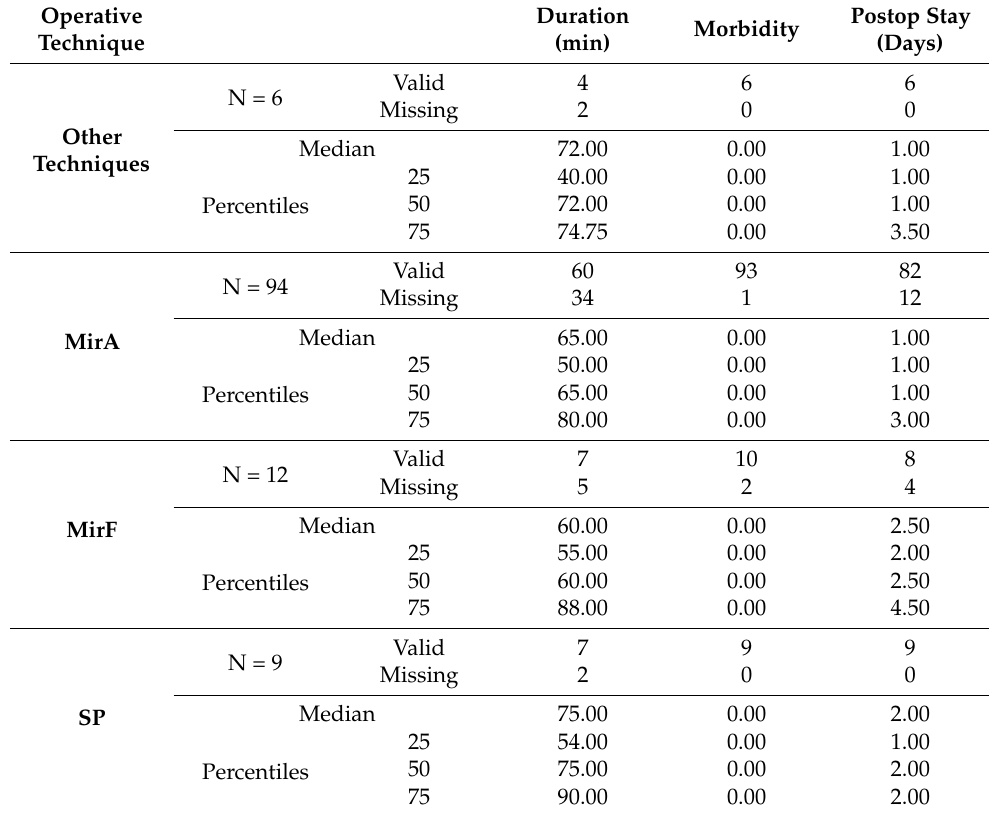
MirA—mirrored American; MirF—mirrored French;